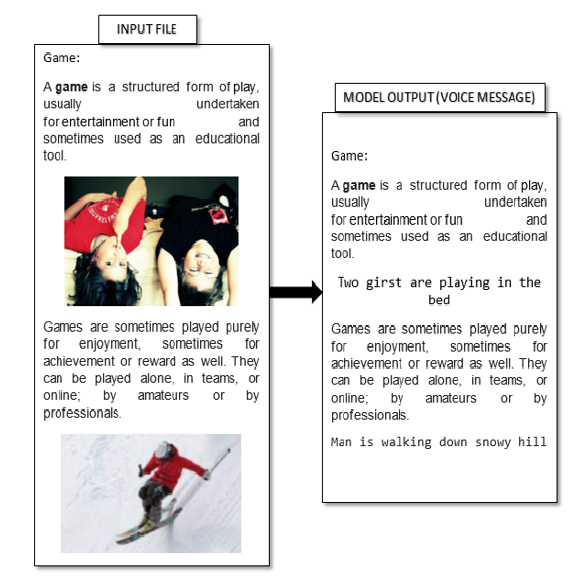
Figure 9. Deep learning Reader Output